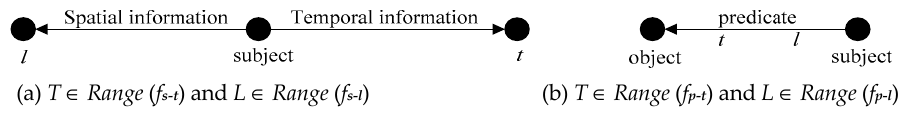
Figure 1. Representation of spatiotemporal information in an stRDFS graph.